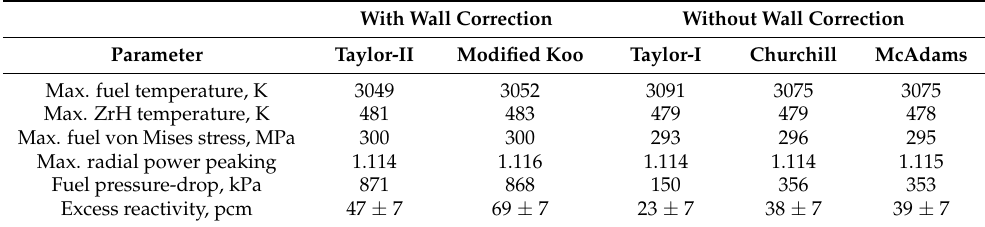
Table 4. Friction factor sensitivity study summary. With Wall Correction Without Wall